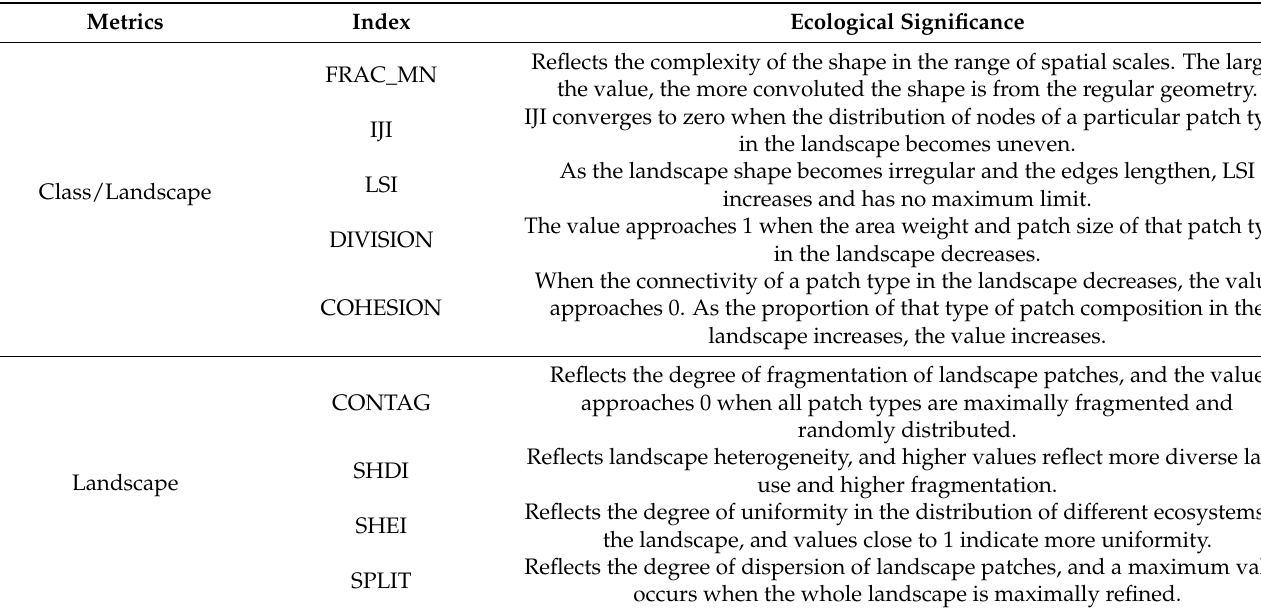
Table 3. Landscape indices and their ecological